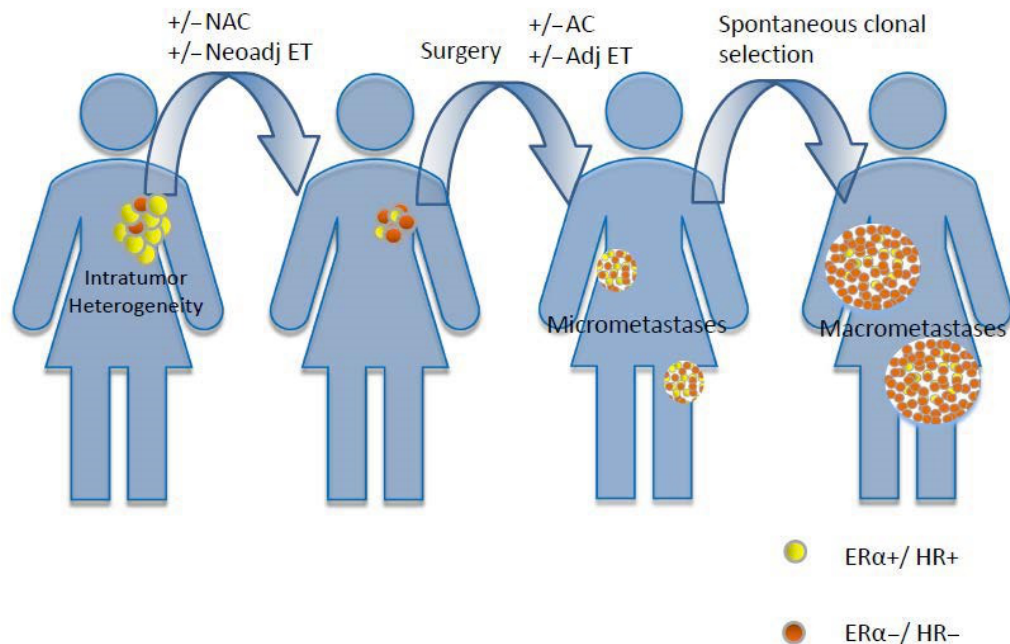
Figure 3. Presence of baseline tumor heterogeneity, with the coexistence of ERα+/ HR+ and ERα -/HR- clones and selective pressure of different treatments, which lead to the progressive selection of tumor lesions enriched for ERα -/HR- cells. NAC: neoadjuvant chemotherapy; Neoadj ET: neoadjuvant endocrine therapy; AC: adjuvant chemotherapy; Adj ET: adjuvant endocrine therapy.